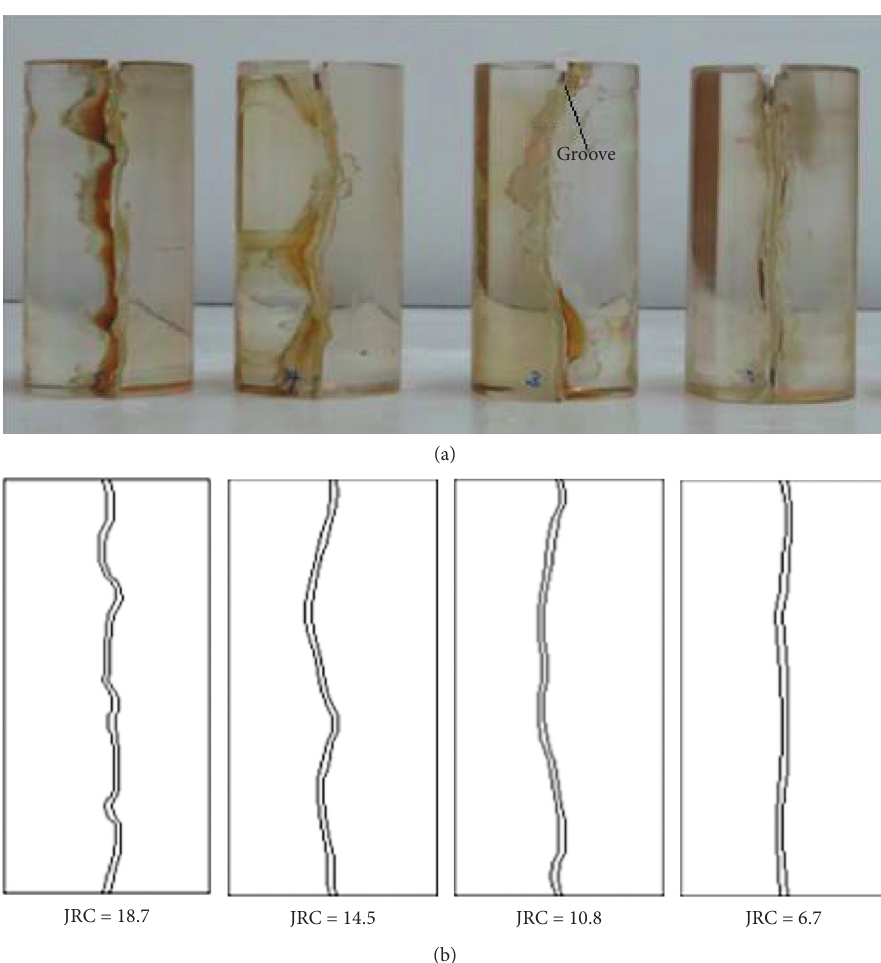
Figure 4: Specimens with prefabricated cracks. (a) Rock-like specimens containing prefabricated cracks with different joint roughness coefficients. (b) Sketch of prefabricated cracks with different joint roughness